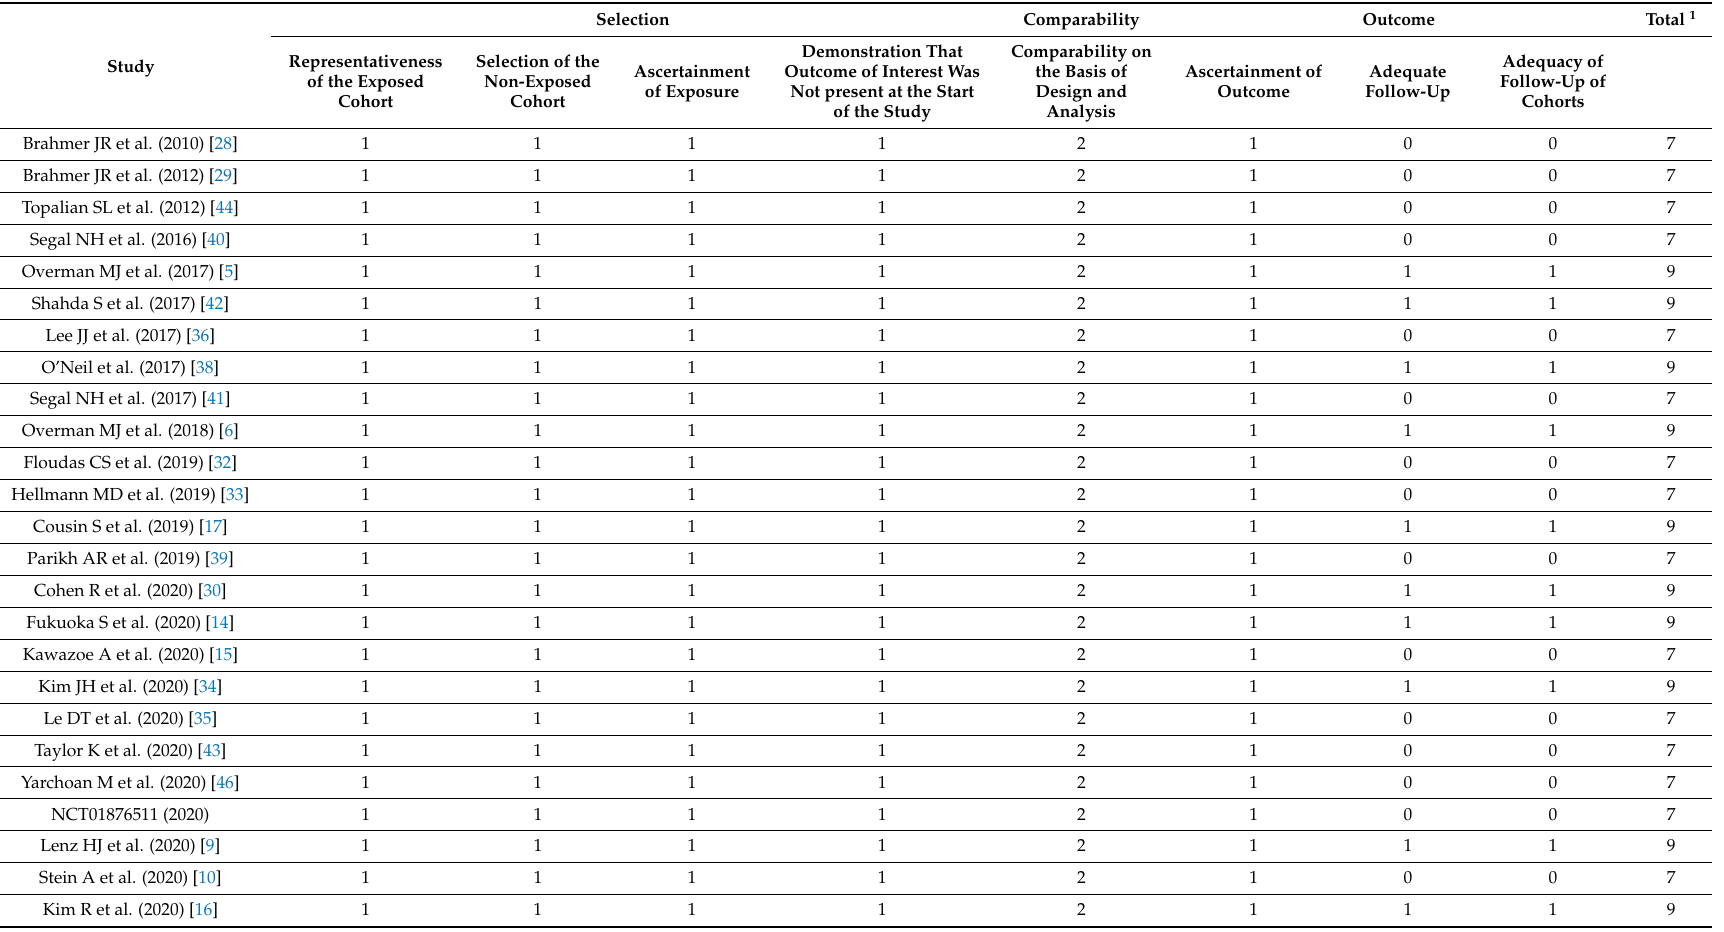
Table 2. The Newcastle–Ottawa scale quality assessment for the 25 non-randomized clinical